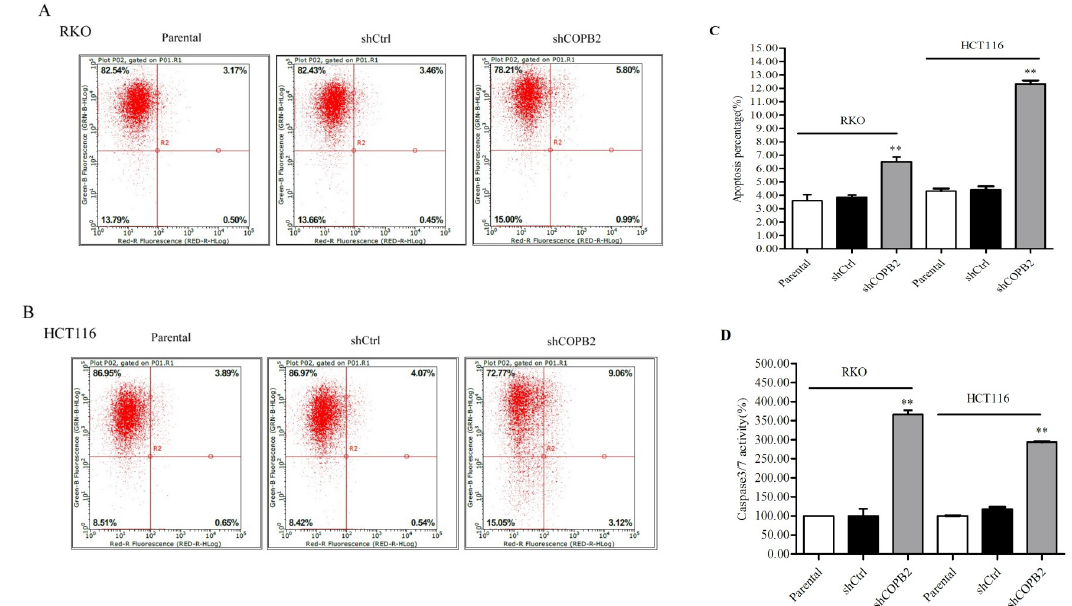
Fig 5. COPB2 knockdown promotes apoptosis of RKO and HCT116 cells and increases Caspase 3/7 activity. ( A-C ) Flow cytometry analysis indicated that COPB2 knockdown significantly promoted cells apoptosis in RKO and HCT116 cells. ( D ) Caspase 3/7 activity was significantly increased in shCOPB2-treated groups of RKO and HCT116 cells. Data are represented as the means ± SD. �� P < 0.01 compared with the shCtrl and parental cells groups.